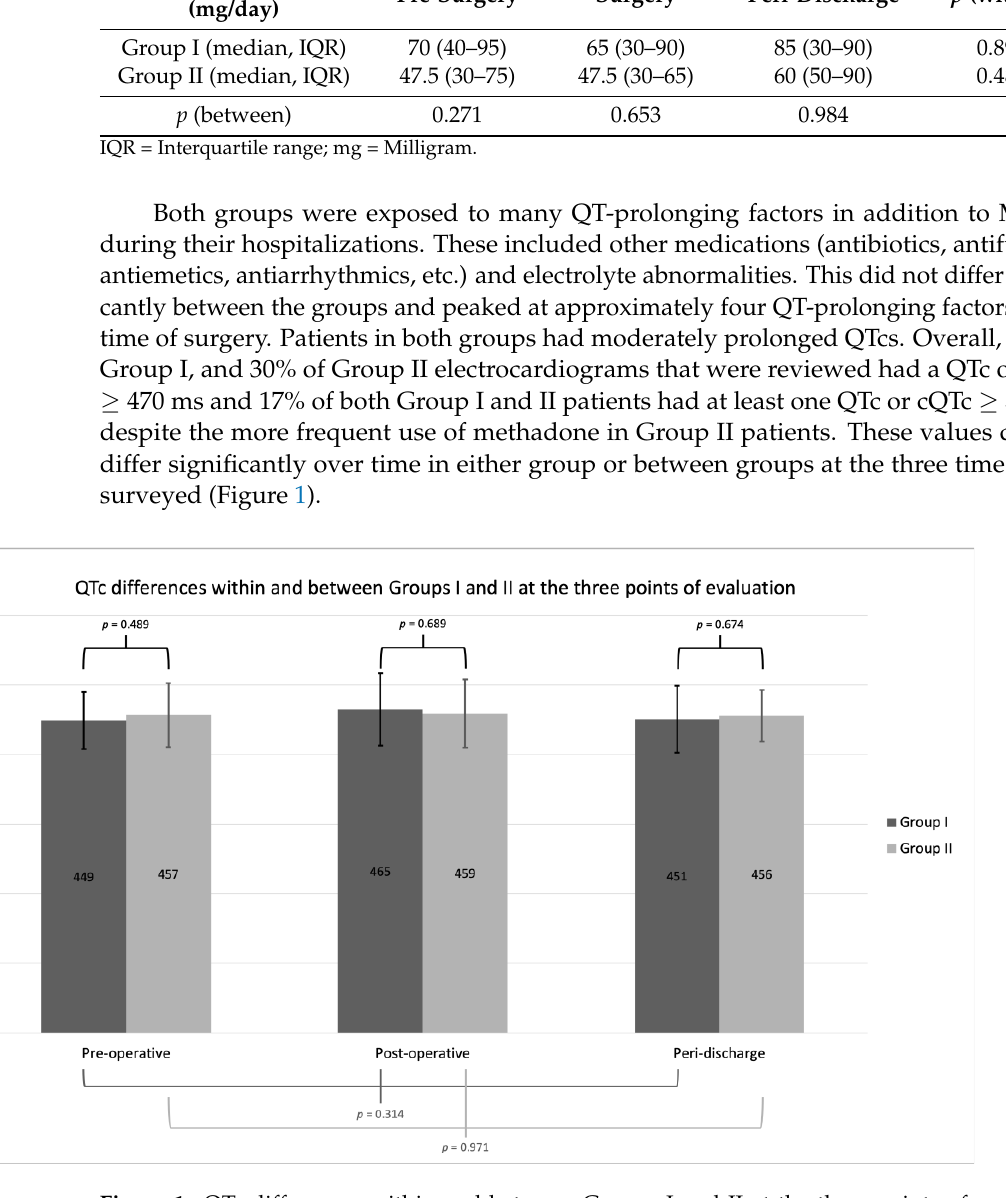
Figure 1. QTc differences within and between Groups I and II at the three points of evaluation (pre-surgery, post-surgery and peri-discharge). ms = milliseconds; QTc = corrected QT (includes QTc corrected for prolonged QRS, cQTc, where appropriate); SD = standard deviation.